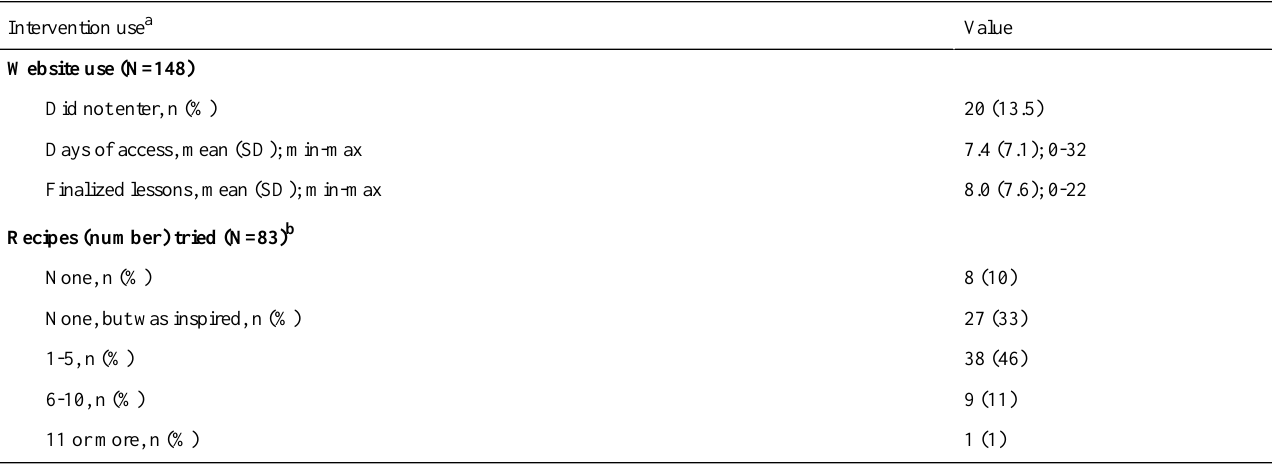
Table 2. Participants’use of the intervention website and recipes tried.